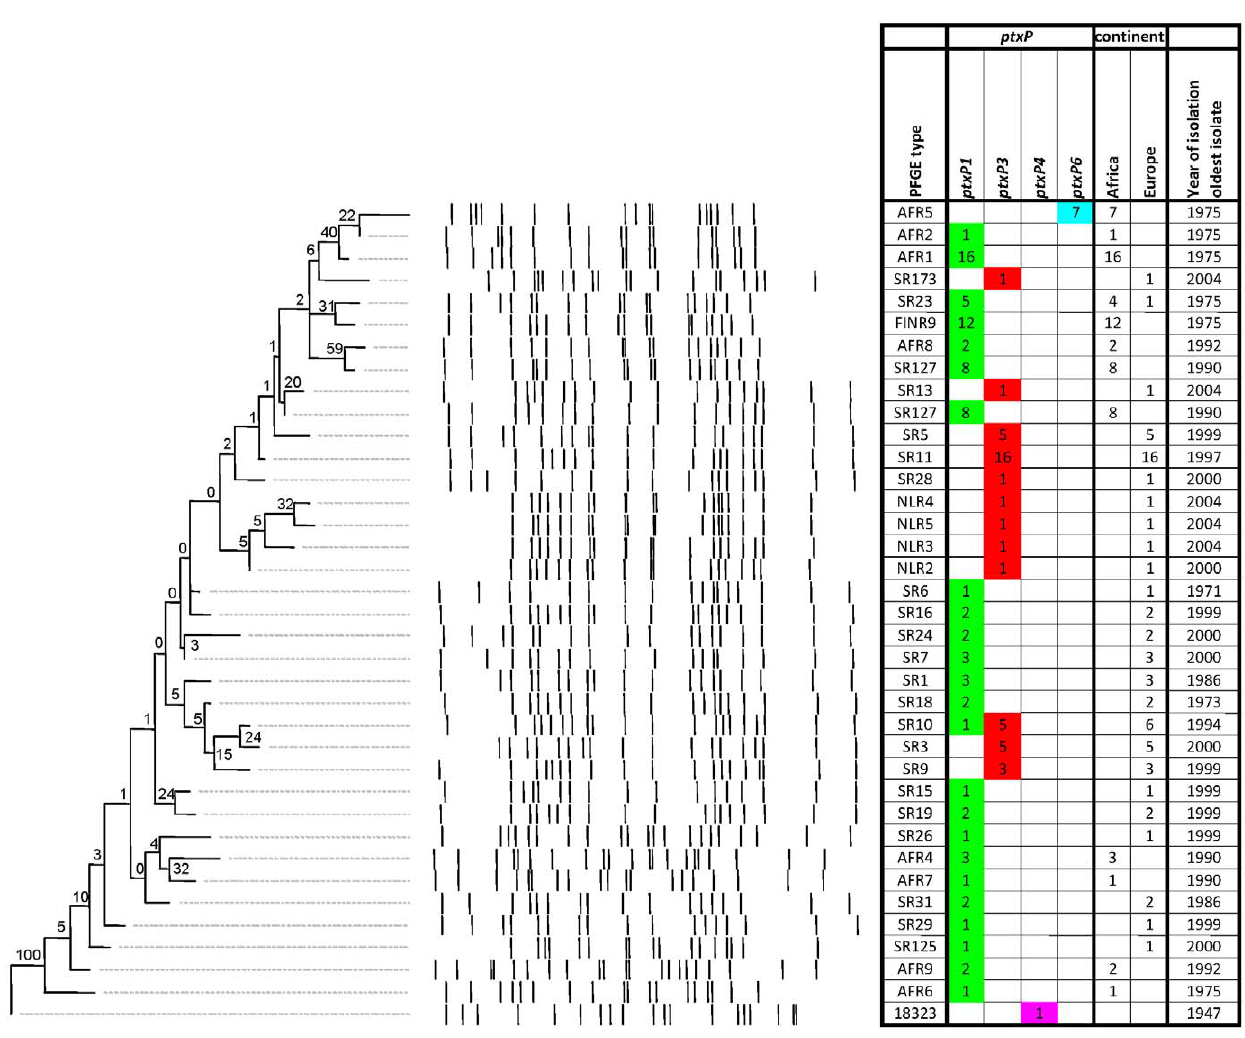
Figure 3. Maximum Parsimony tree of 125 B.pertussis isolates based on PFGE. See legends to Fig. 1 for further details.